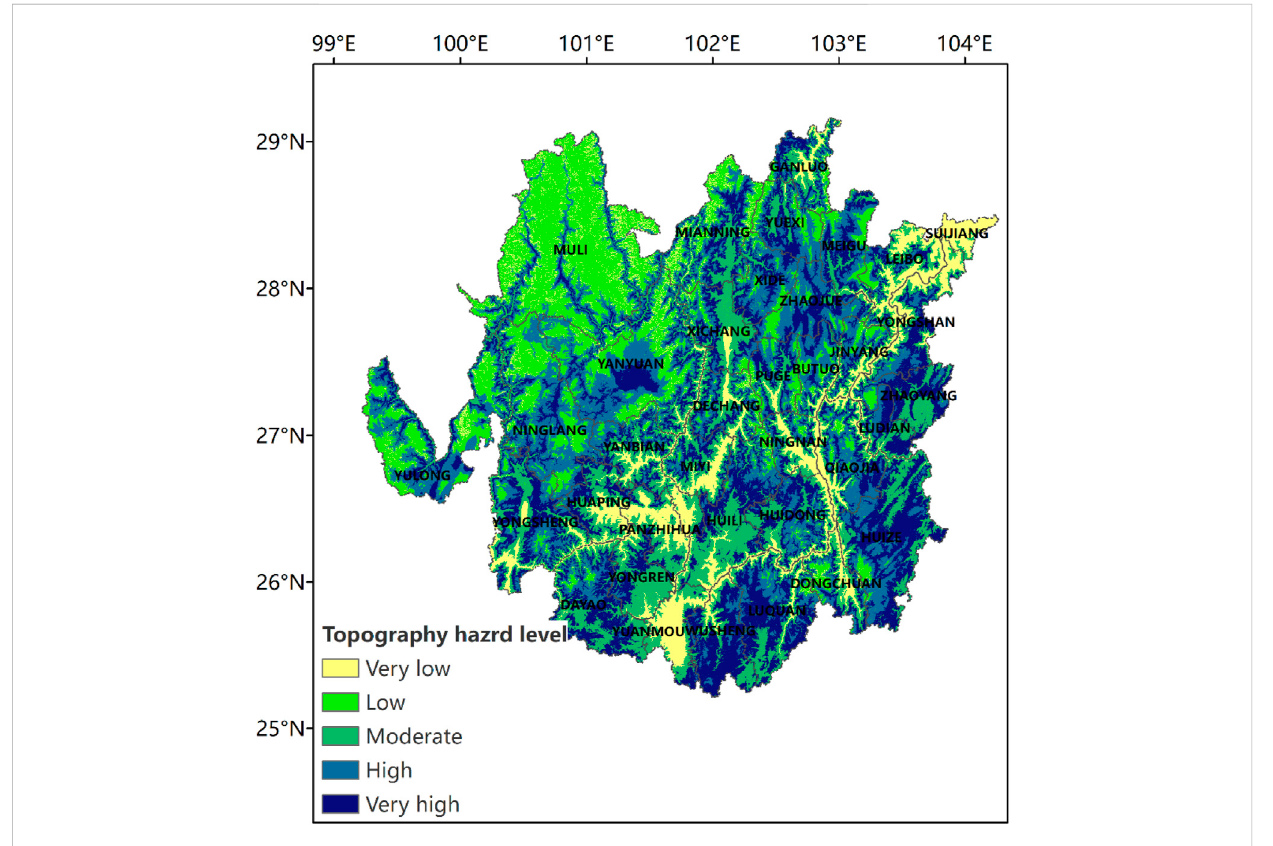
FIGURE 7 Spatial pattern of topography